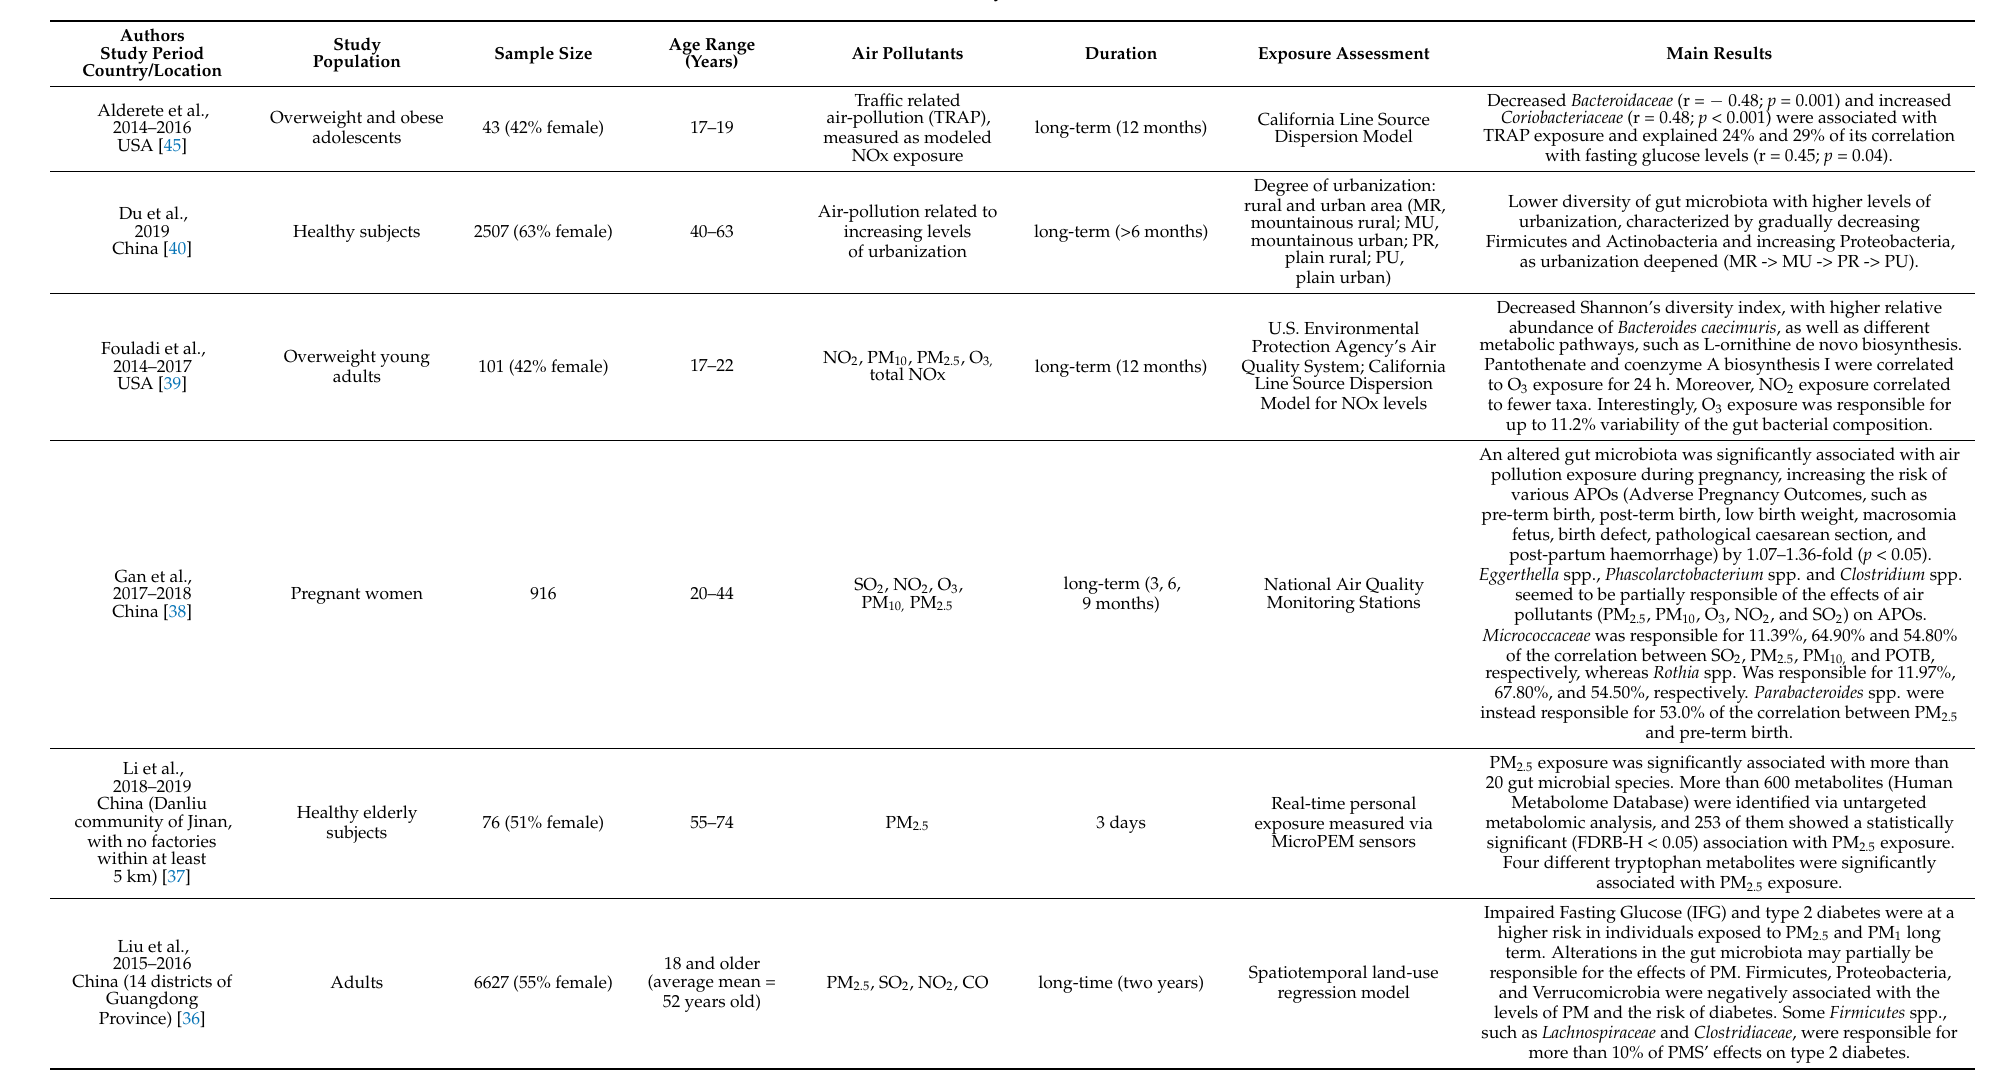
Table 1. General characteristics of the studies included in the systematic